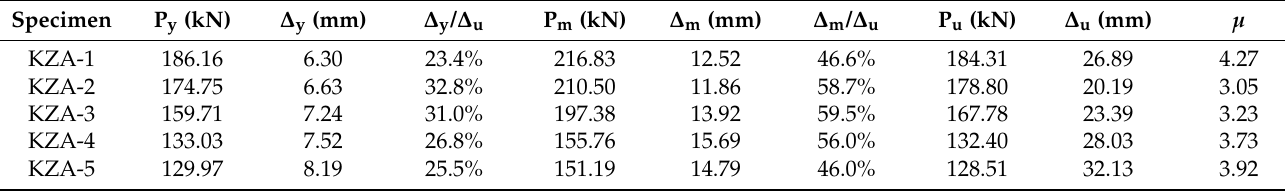
Table 5. The ductility coefficients of specimens.